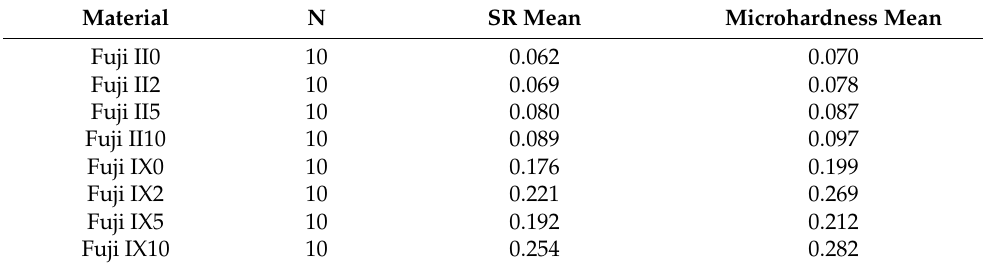
Table 1. Descriptive statistics for surface roughness (SR) and